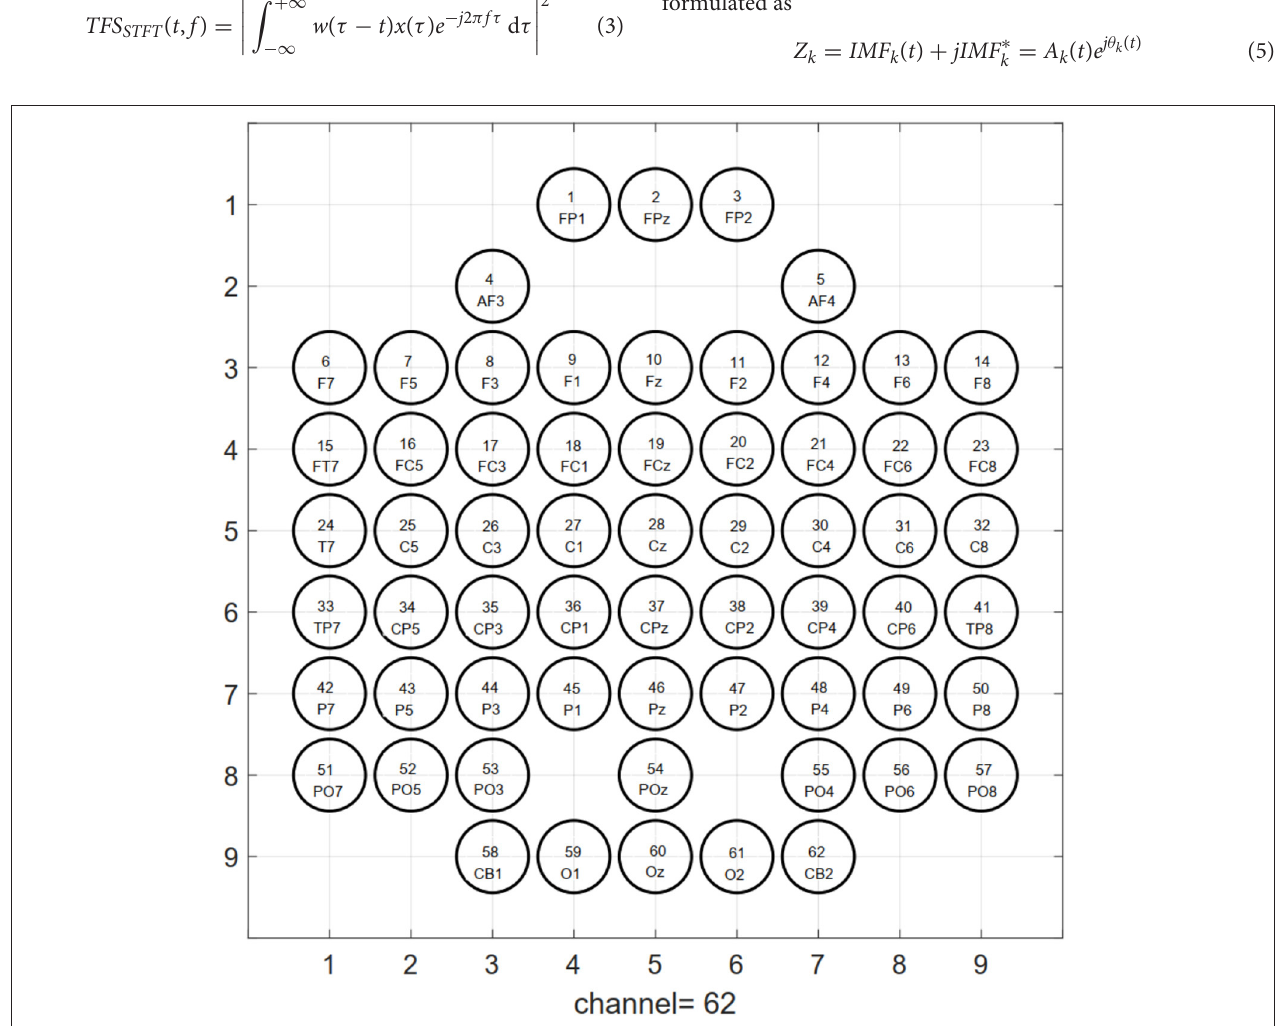
FIGURE 2 | Topological structure map of 64-electrode channels mapped to a two-dimensional picture. The circle represents the electrode, and the label inside is the serial number and name of the electrode. The left and right mastoid electrodes (M1, M2) of the 64-lead electrodes are reference electrodes when collecting signals, so they are not used as signal input for emotion